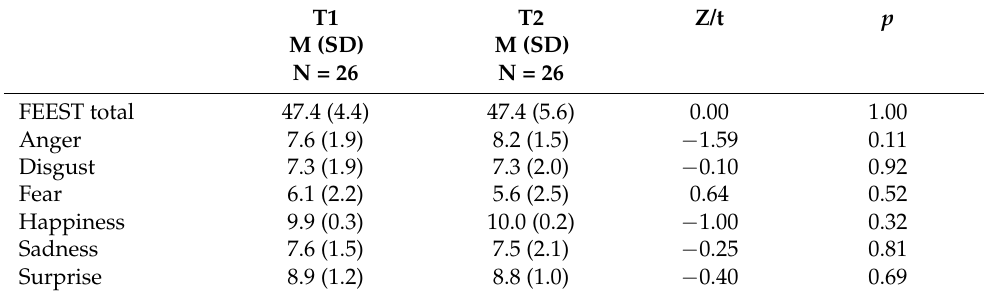
Table 3. Paired comparisons between preoperative and postoperative scores on test for emotion recognition. T1